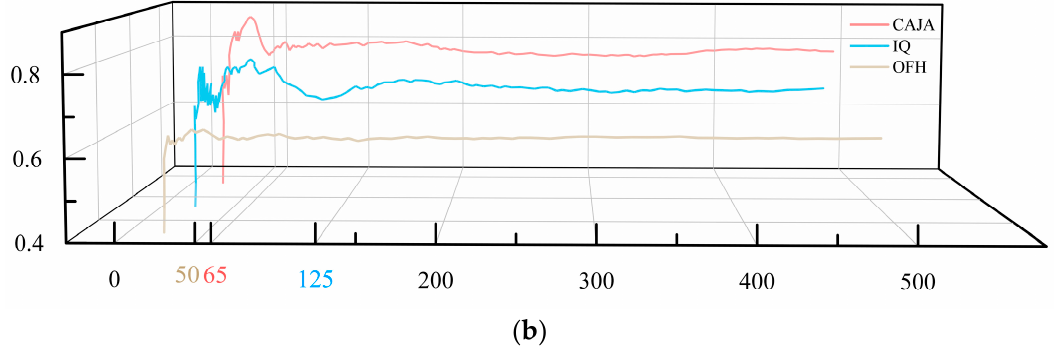
Figure 9. Comparison diagram of average transmission income.